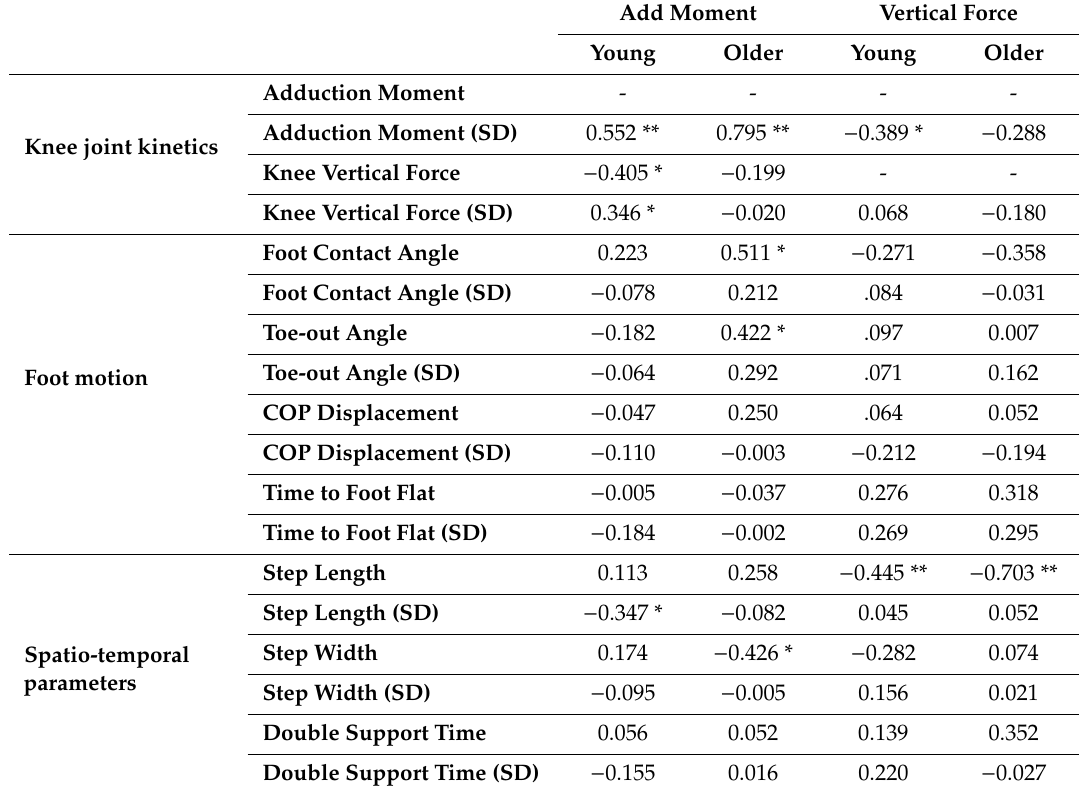
Table 1. Correlations, knee joint kinetics (adduction moment and vertical force) and gait parameters; SD = standarddeviationindicatingintrasubjectvariabilityovermultiplegaitcycles. * = p < 0.05, ** = p <